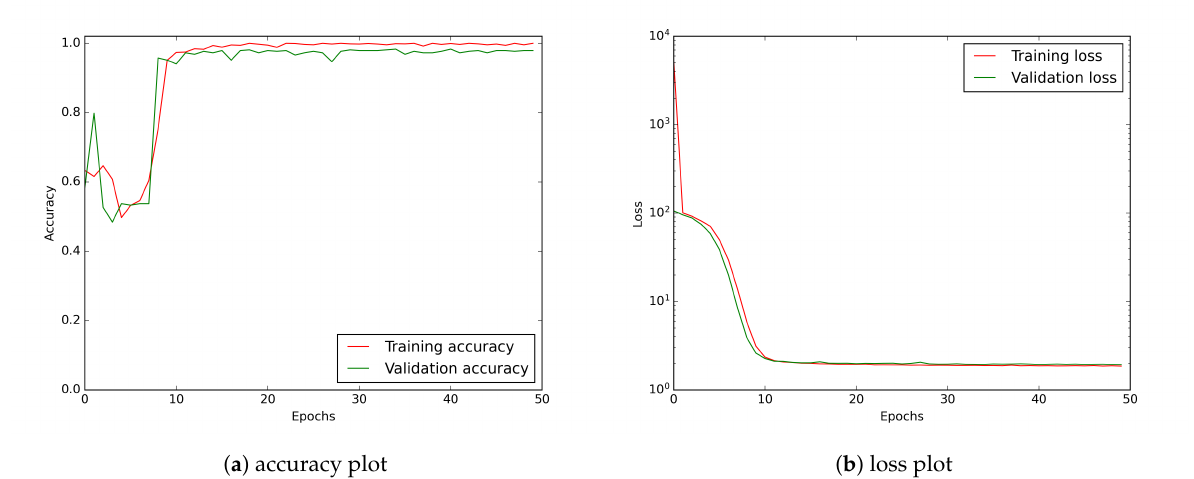
Figure 14. CNN model learning history for an input tensor consisting of raw data merged with D2:20 wavelets: ( a ) accuracy plot, ( b ) loss curve. A logarithmic scale has been applied to the loss plot to keep a better